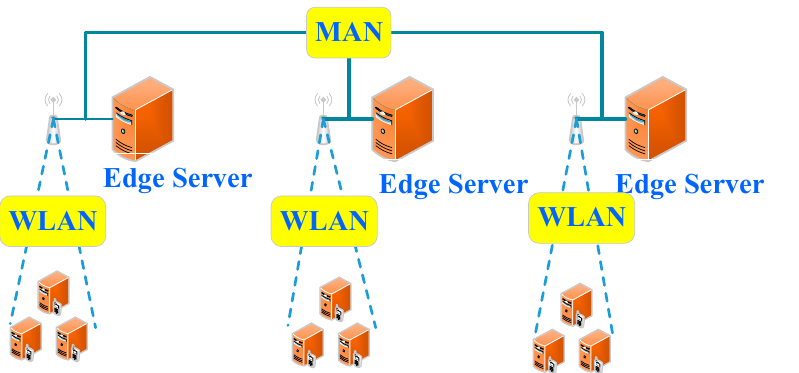
Figure 2. Basic edge computing (MAN: metropolitan area network and WLAN: wireless local area network).